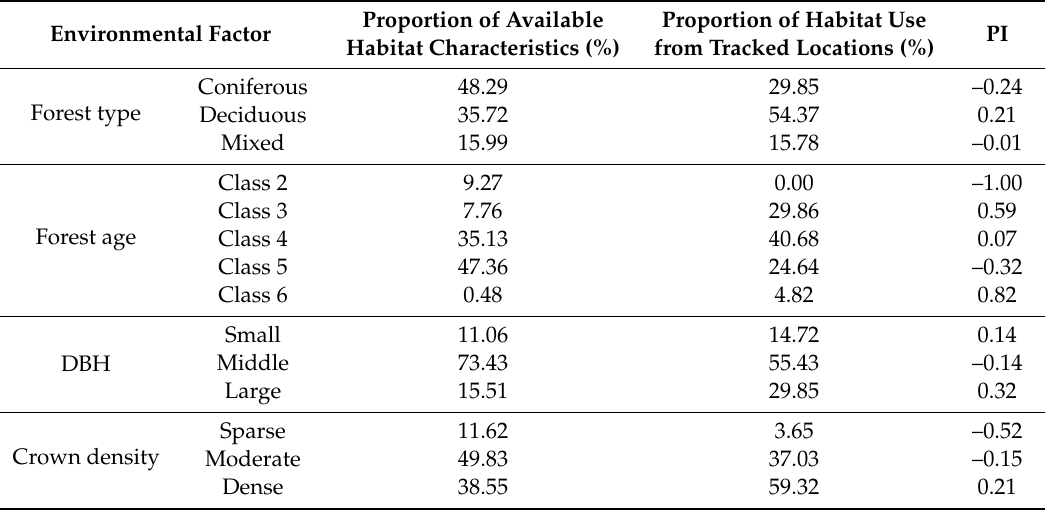
Table 5. Proportion of available habitat characteristics, proportion of habitat use from tracked locations, and Jacob’s preference index (PI) of Siberian flying squirrels by environmental factors at Mt. Baekwoon, Gangwon Province, South